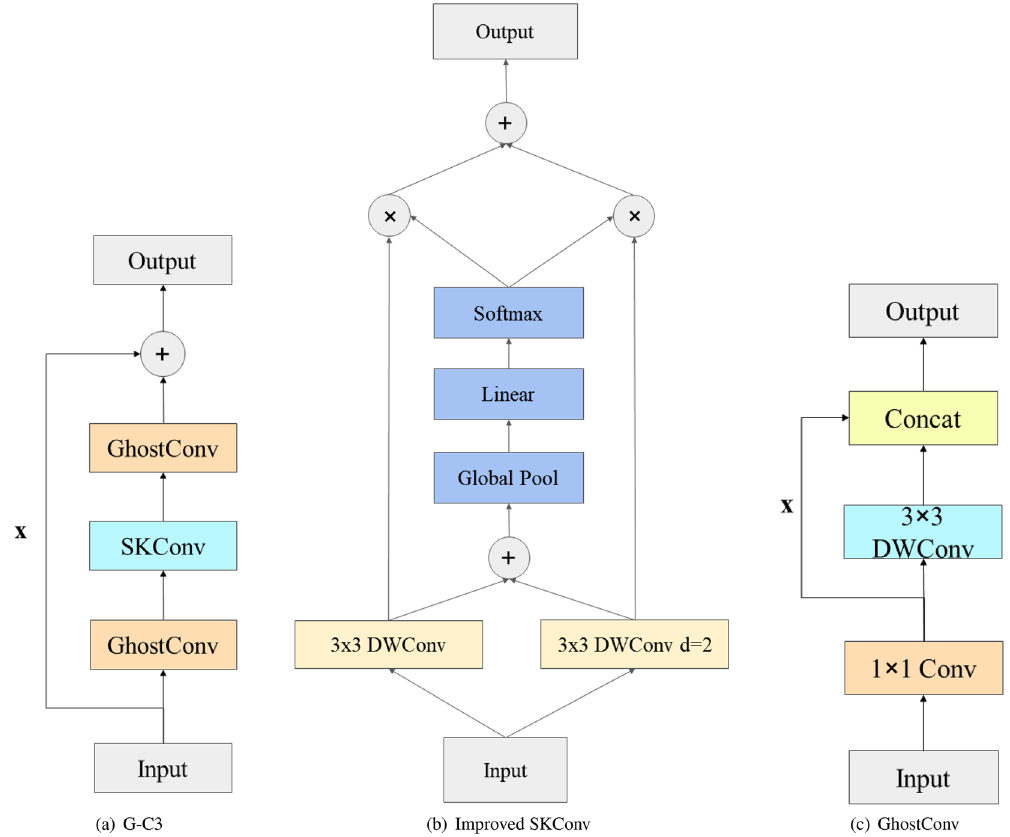
Figure 3. The structures of G-C3, improved SKConv and